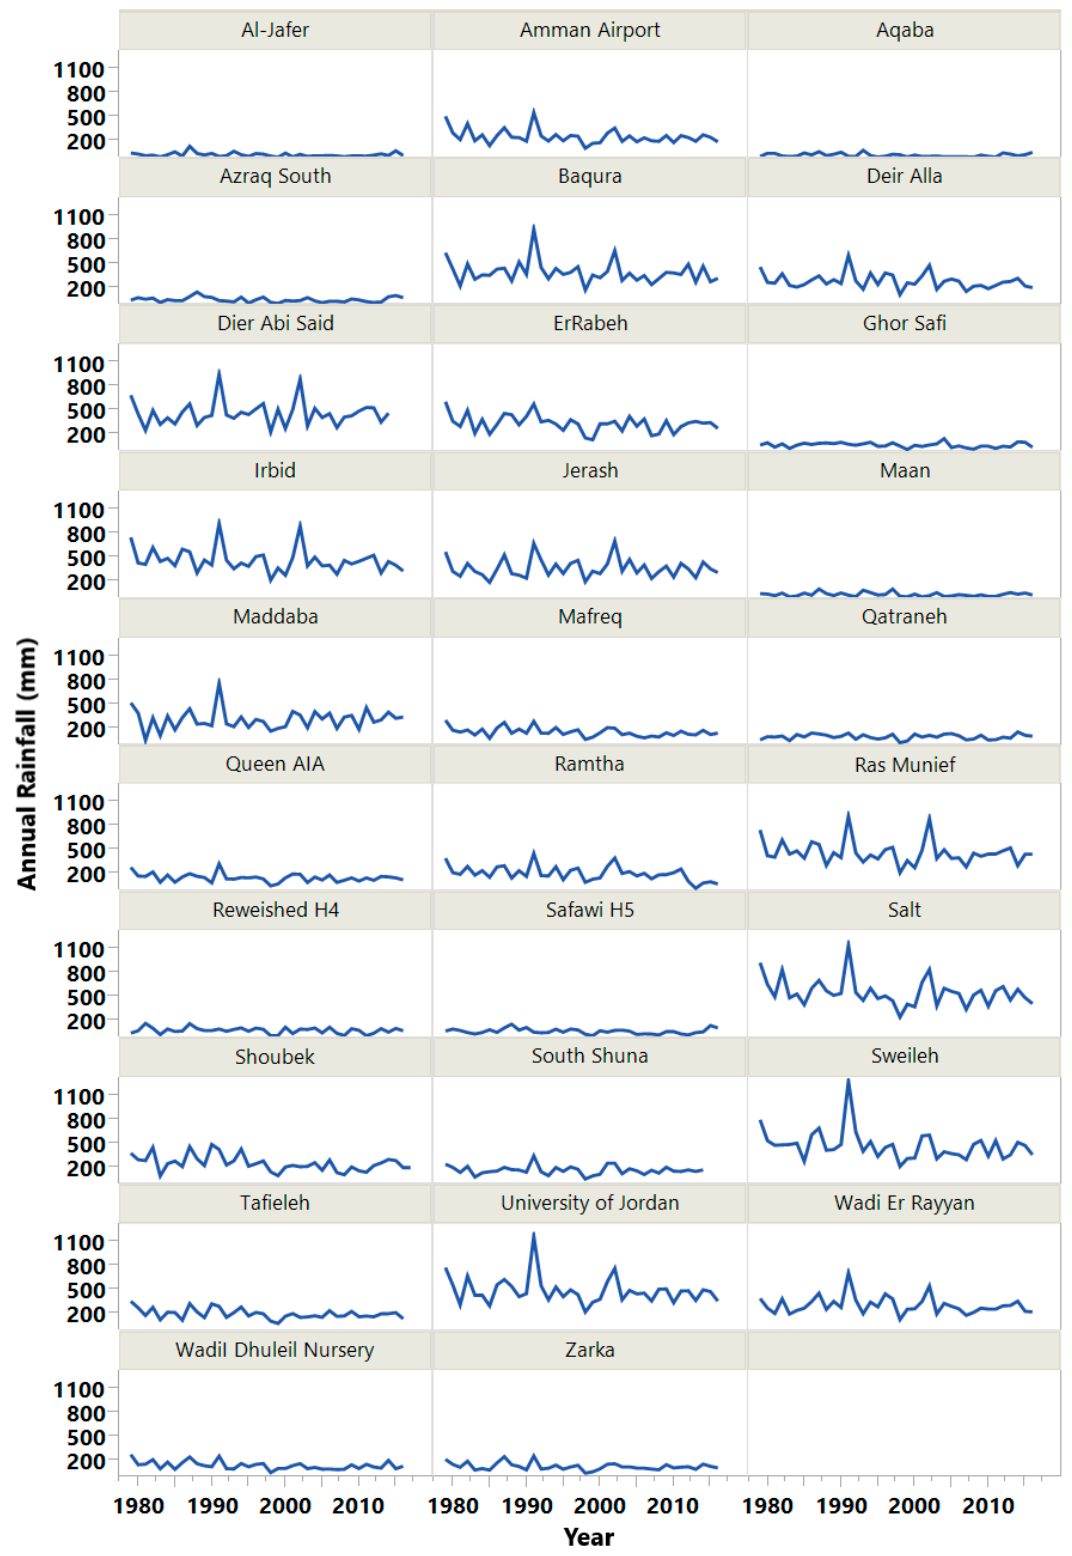
Figure 3. Historical rainfall distribution by station from 1980 to 2017.